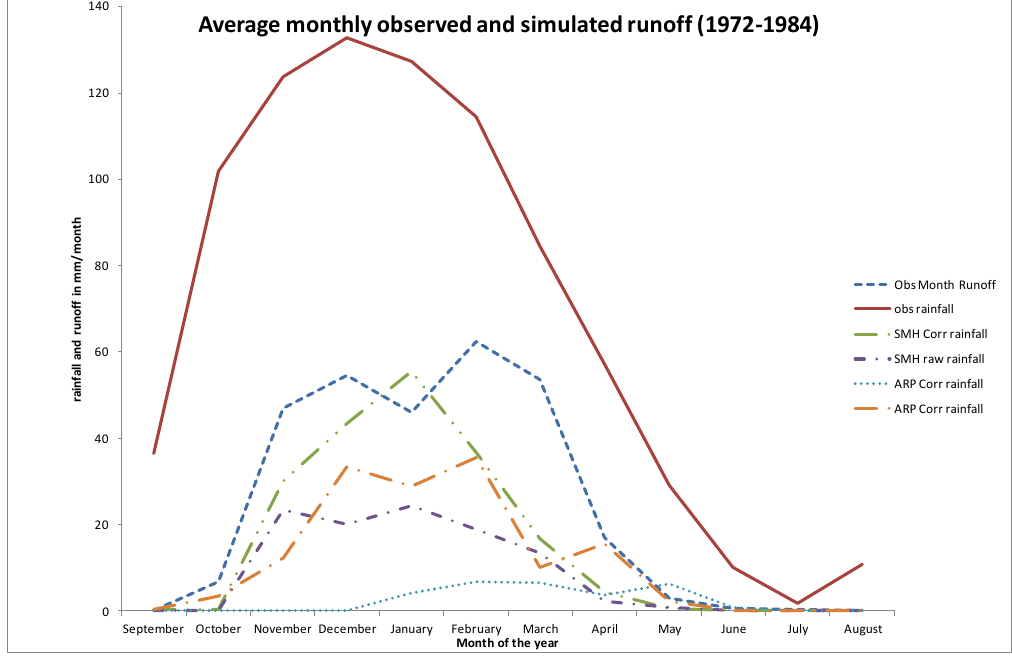
Figure 7. Comparison of simulated monthly runoff to observed monthly